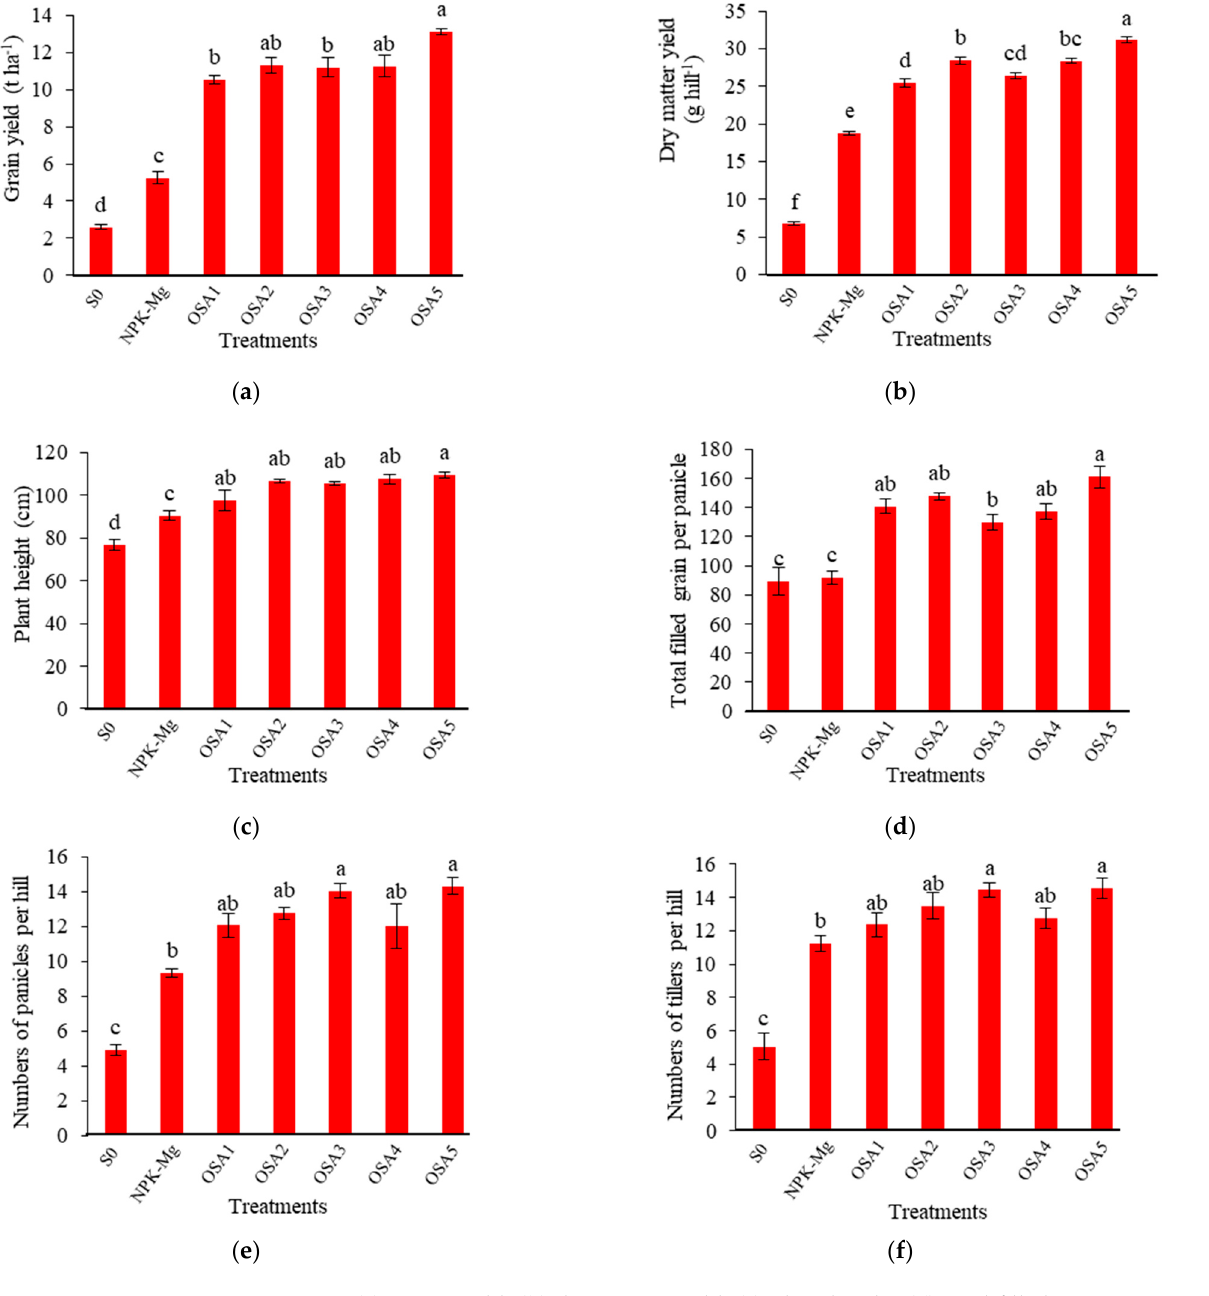
Figure 4. ( a ) Grain yield, ( b ) dry matter yield, ( c ) plant height, ( d ) total filled grain per panicle, ( e ) number of panicles per hill, and ( f ) number of tillers per hill of rice plants in relation to the addition of chemical fertilizers and organic soil amendments after the second cropping cycle. Means with different letters indicate significant difference using Tukey’s test at p ≤ 0.05 and error bars represent standard error.